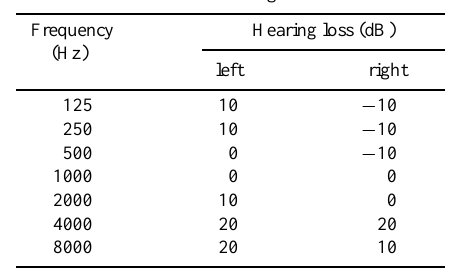
Table 1 Pure tone audiogram